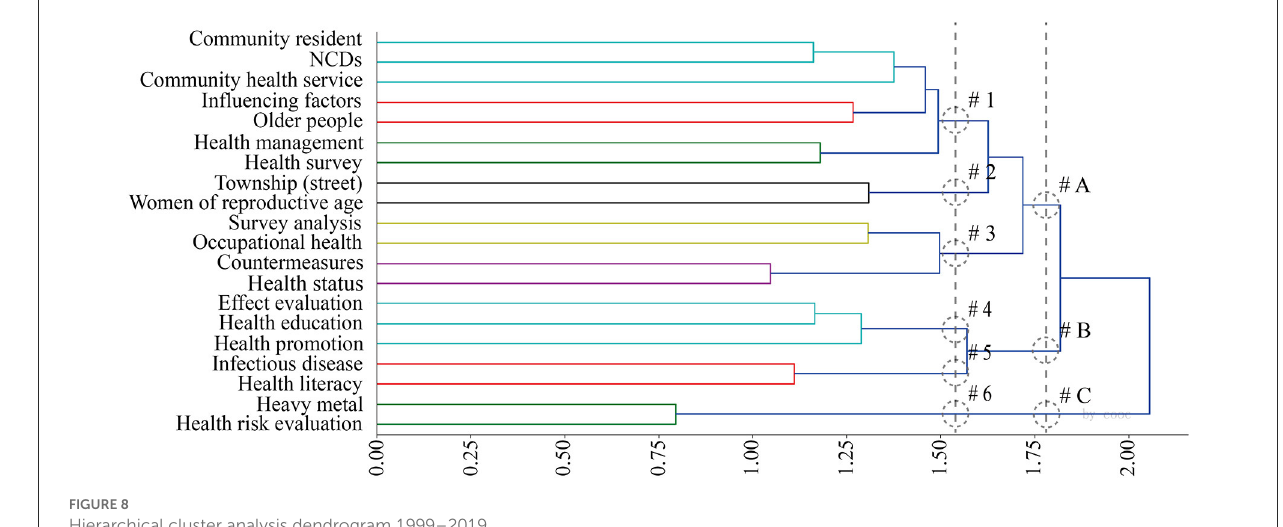
FIGURE8 Hierarchical cluster analysis dendrogram